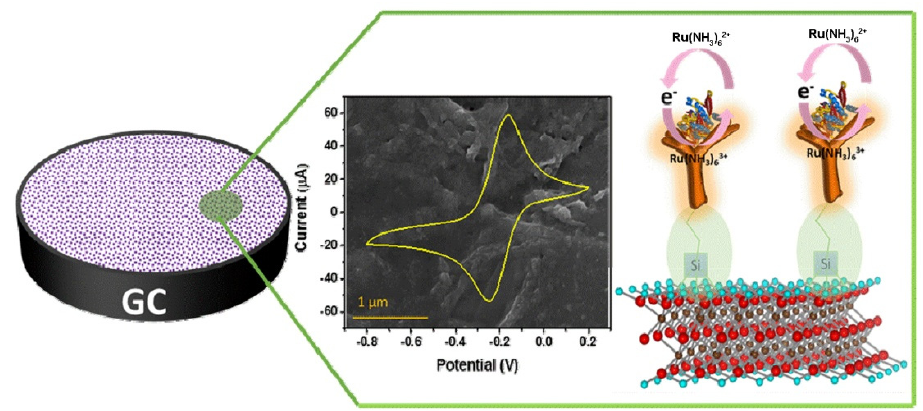
Figure 2. Schematic diagram of the mechanism for electrochemical CEA detection. Adapted with permission from Ref. [48]. 2018, Elsevier.